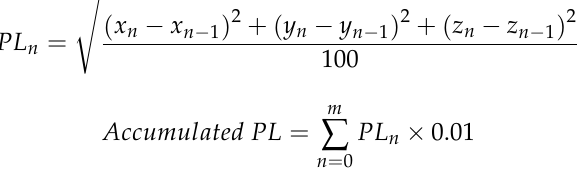
Figure 1. Illustrative scheme of the small-sided games. Blue and white dots represent outfield players, the position in the pitch is solely an example, red and green dots represent the goalkeepers.